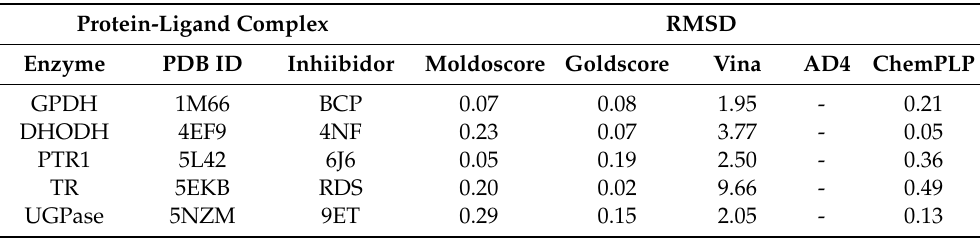
Table 9. Information on the crystalline structures and the root-mean-square deviation (RMSD) values for the poses obtained by